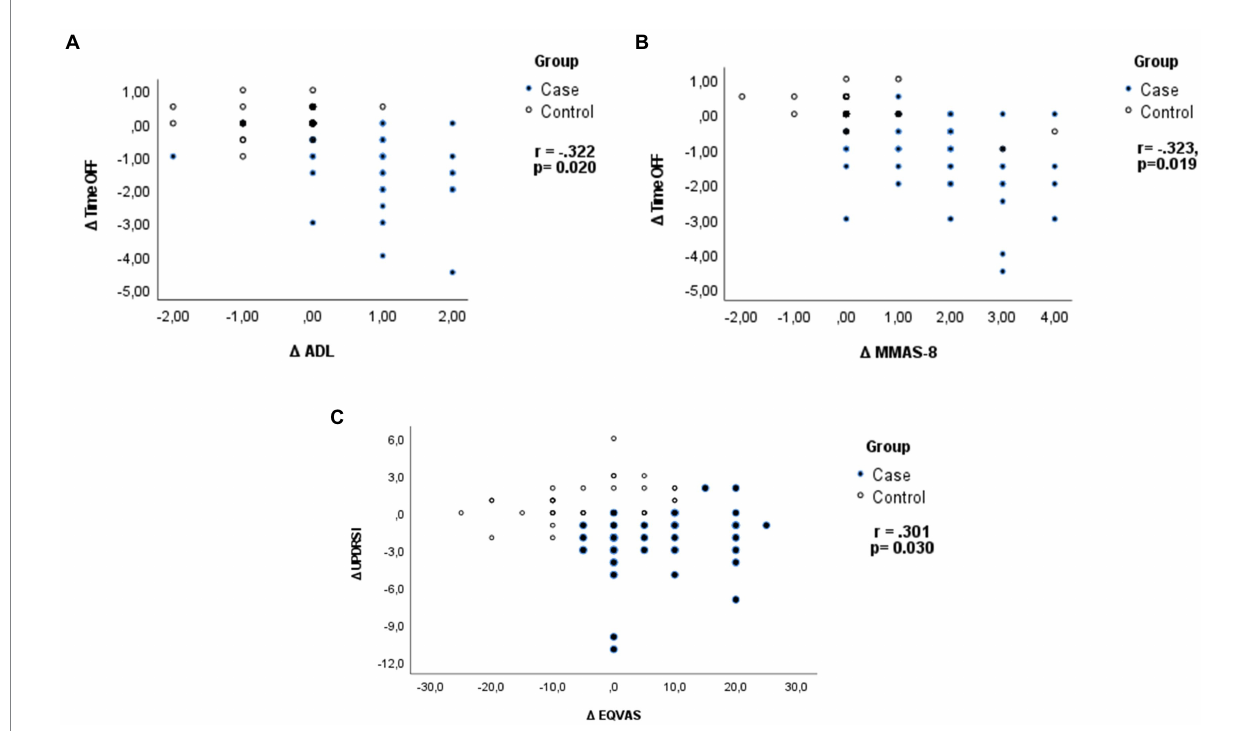
FIGURE 3 Pearson’s correlation coefficient: (A) Analysis of relation between OFF time reduction and the improvement in functional independence (ADL) and (B) medications adherence (MMAS-8), and (C) between the improvement in UPDRS I and Δ EQVAS.